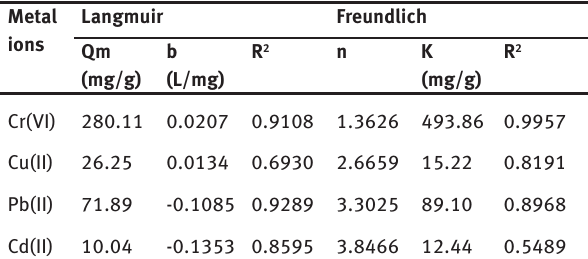
Table 3: Related constants and linear regression coeffcients of Langmuir and Freundlich fitting for Cr(VI), Cu(II), Pb(II) and Cd(II) adsorption onto GO-NH 2